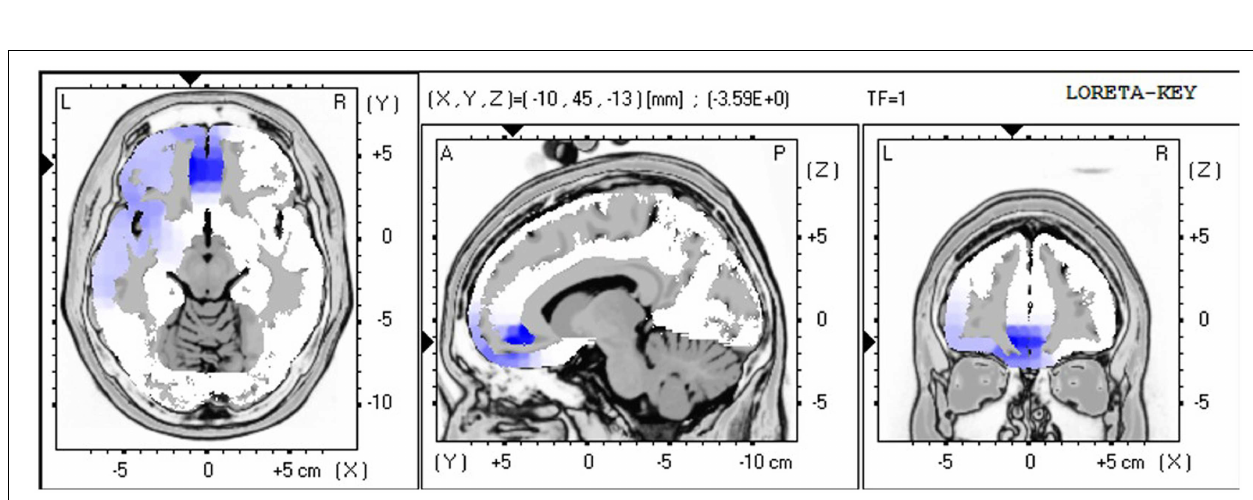
FIGURE 5 | LORETA non-parametric voxel-wise comparison map betweenALS and control groups in the P3 time window . Blue: significantly lower activity in ALS.